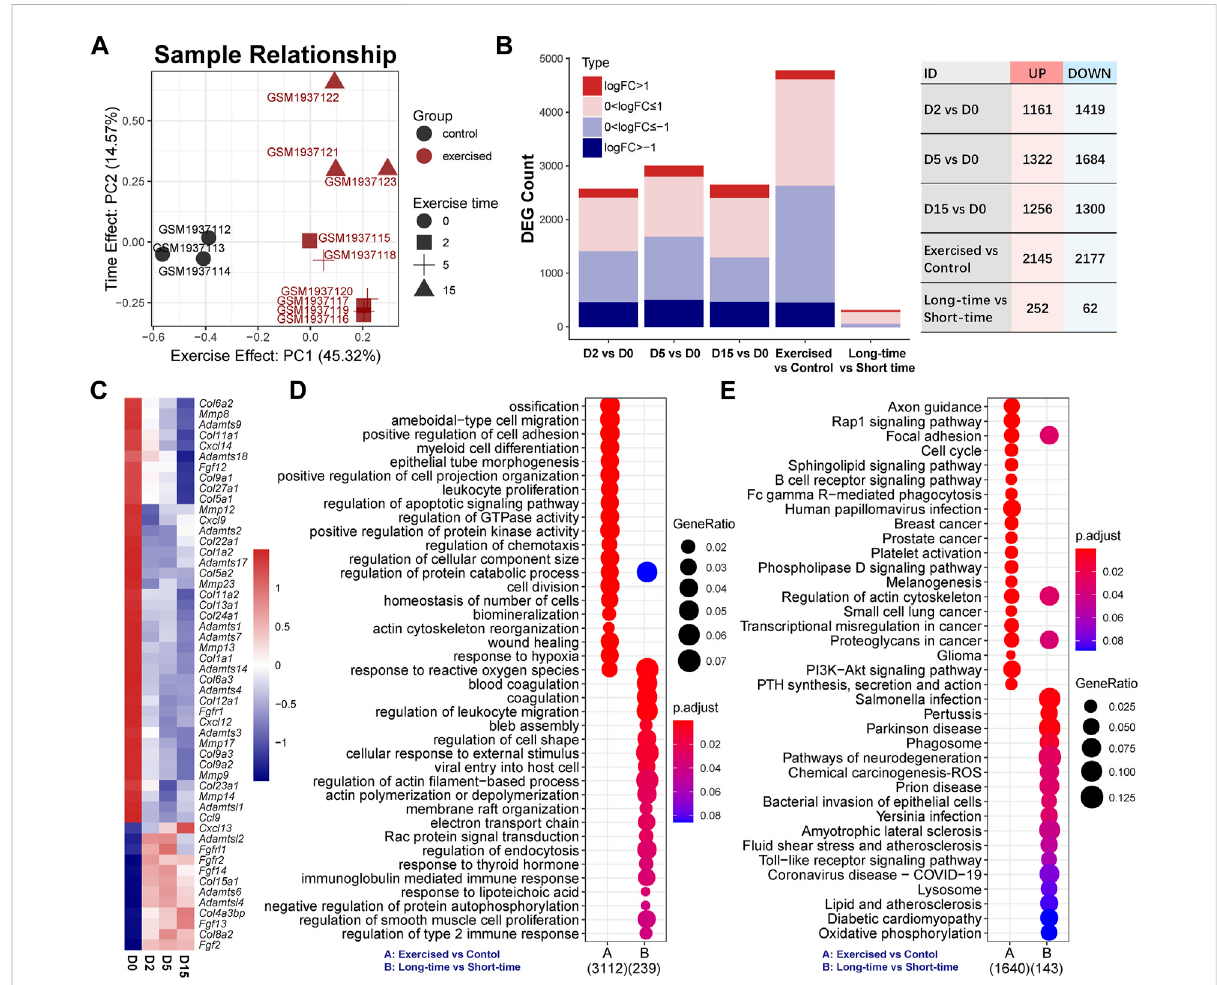
FIGURE 1 Exercise has a notable effect on the cartilage transcriptome. (A) Sample relationship estimated by principal component analysis. PC1, the fi rst principal component; PC2, the second principal component. (B) The numbers of differentially expressed genes (DEGs) in serial comparisons. FC, fold-change value; DEG, differentially expressed gene. (C) The expression of collagens (COLs), matrix metallopeptidases (MMPs), tissue inhibitors of matrix metalloproteinases (TIMPs), a disintegrin and metalloproteinase with thrombospondin motifs (ADAMTS) family, C-X-C motif chemokine ligands (CXCLs), chemokine (C-C motif) ligands (CCLs), and fi broblast growth factors (FGFs) and receptors (FGFRs). (D) GO analysis and (E) KEGG